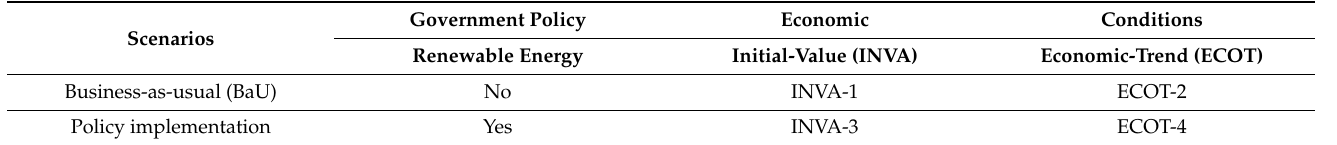
Table 1. Number of scenarios considered.